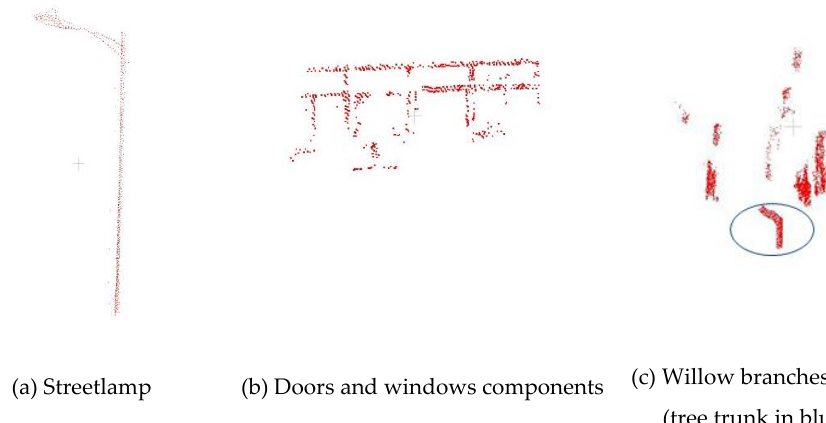
Figure 9. The pseudo-tree trunk was extracted.